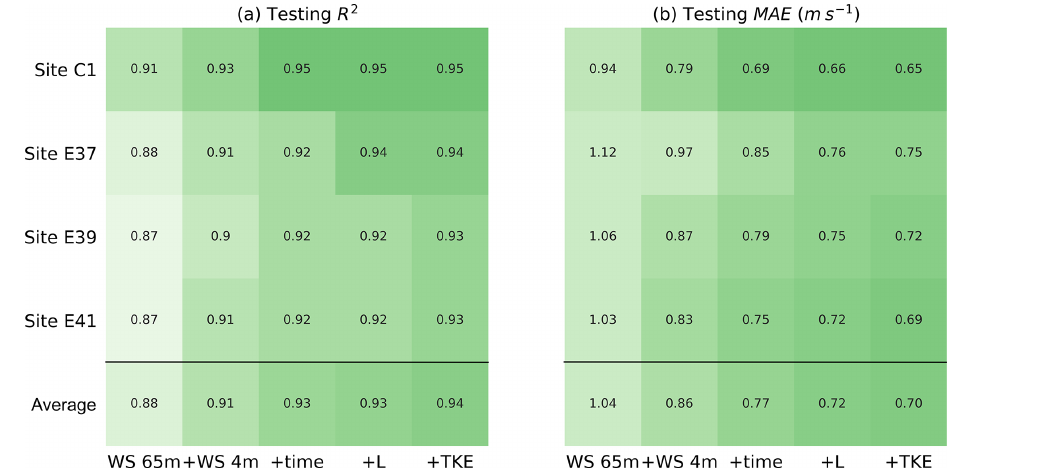
Figure 6. Testing R 2 and MAE in predicting the 30min average wind speed at 143ma.g.l. for the different sites and input feature combina- tions.